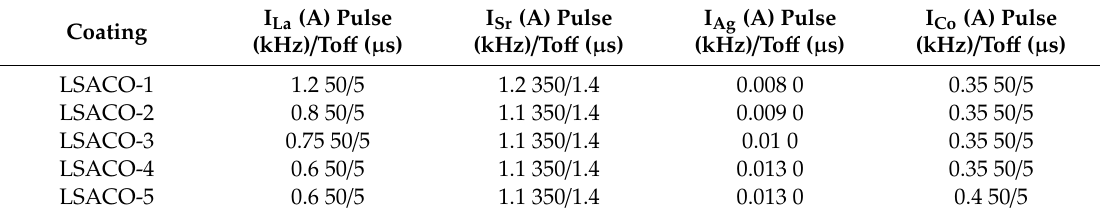
Table 2. Sputtering parameters used for LSACO